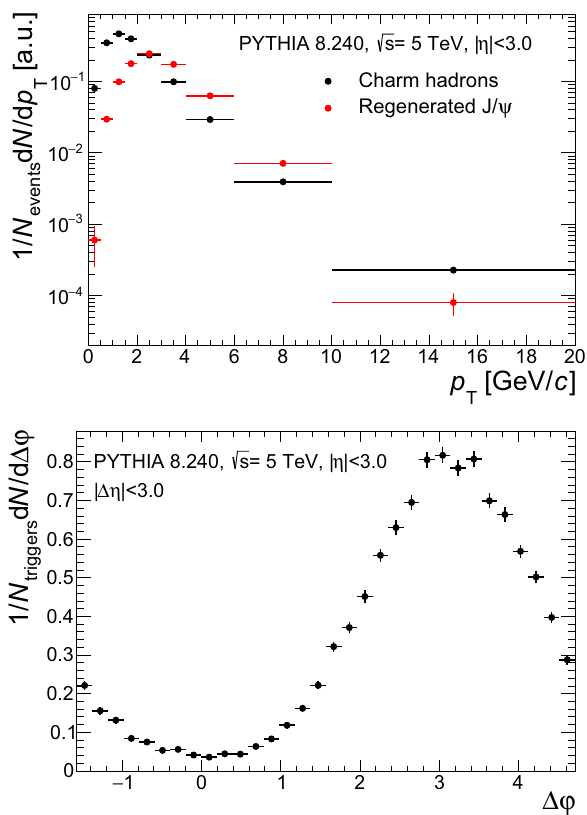
Fig. 5 Predictions for regenerated J /ψ hadrons based on PYTHIA simulations, see text for details. Top: the comparison between the p T spectra for charmed “quarks” and regenerated J /ψ . Note that the spec- tra have been scaled to have a similar magnitude so the shape is easy to compare. Bottom: azimuthal correlations between regenerated J /ψ and their two correlated charm-hadron